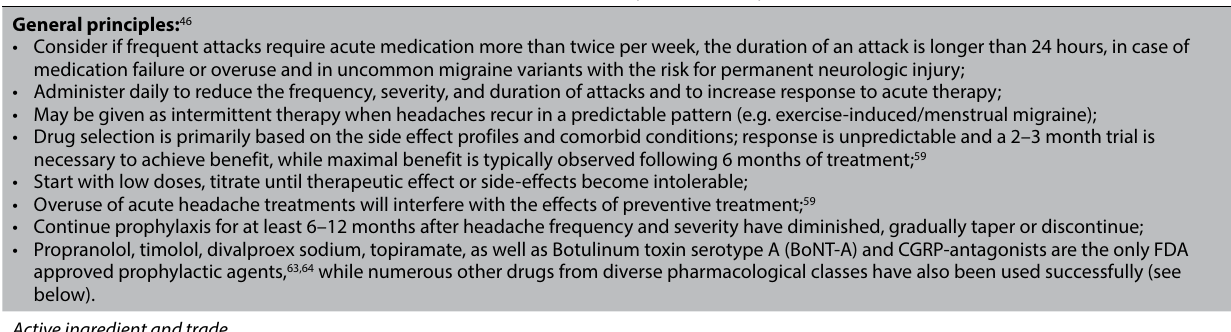
Preventive (prophylactic